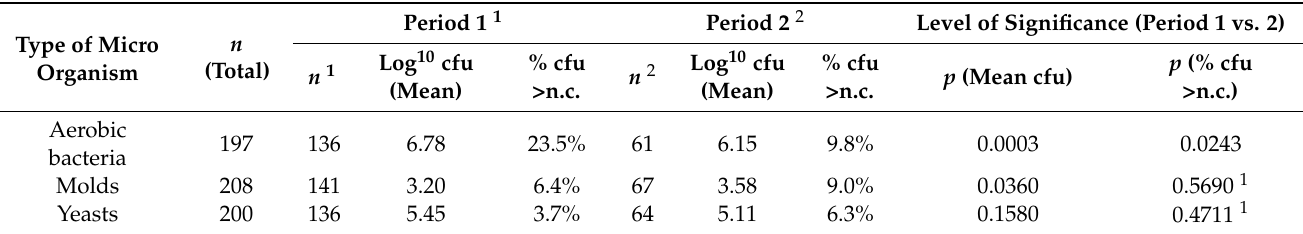
Table 4. Average microbial plate counts and proportional frequency of deviations in hygienic quality of cereals regarding dry matter content (DM) and microbiological quality (assessed using VDLUFA orientation values [14]) in investigation periods 1 and 2 (1993–1999 and